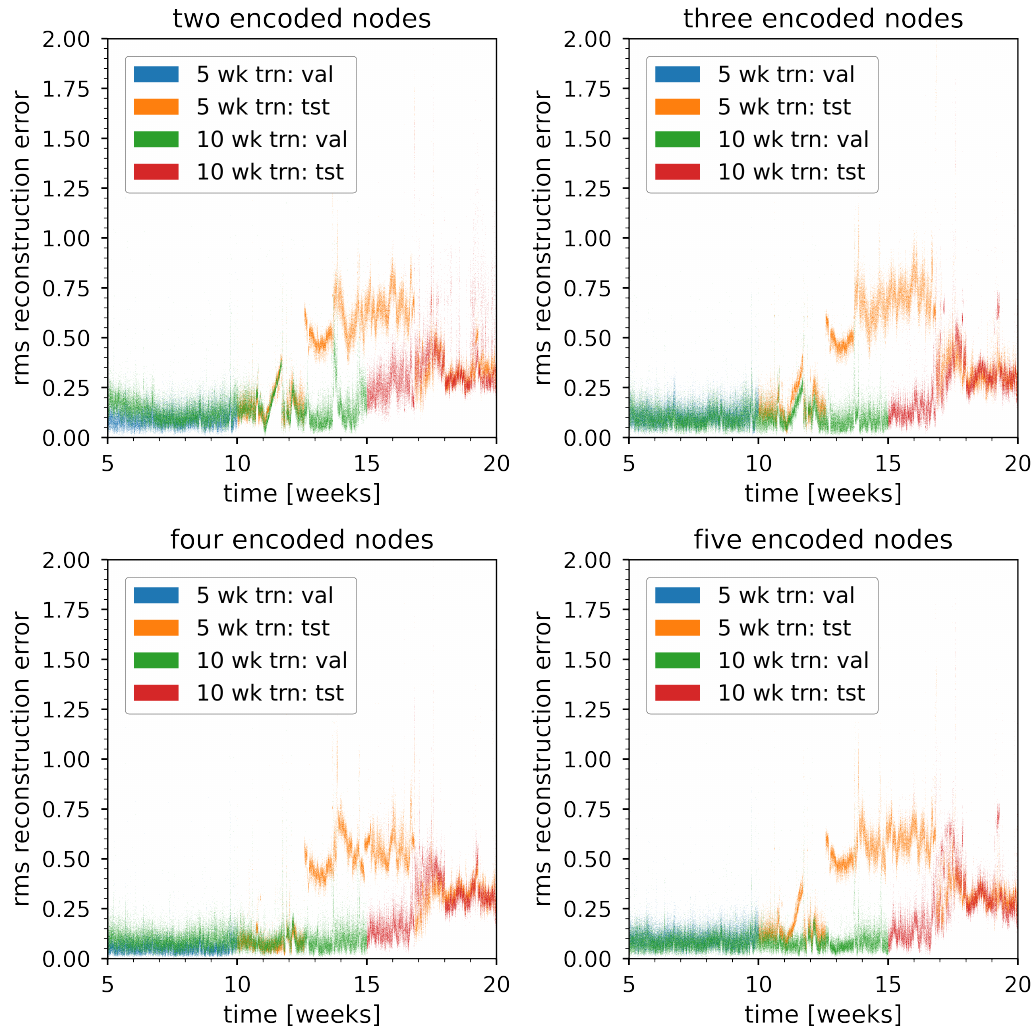
Figure 17. Root Mean Squared (RMS) reconstruction error as a function of time for the two autoencoders. Orange/Blue was trained and validated on the first 5 weeks of data while Red/Green was trained and validated on 10 weeks of data. Orange is the Blue network tested on 10 weeks of data and Red is the Green network tested on the 5 weeks of